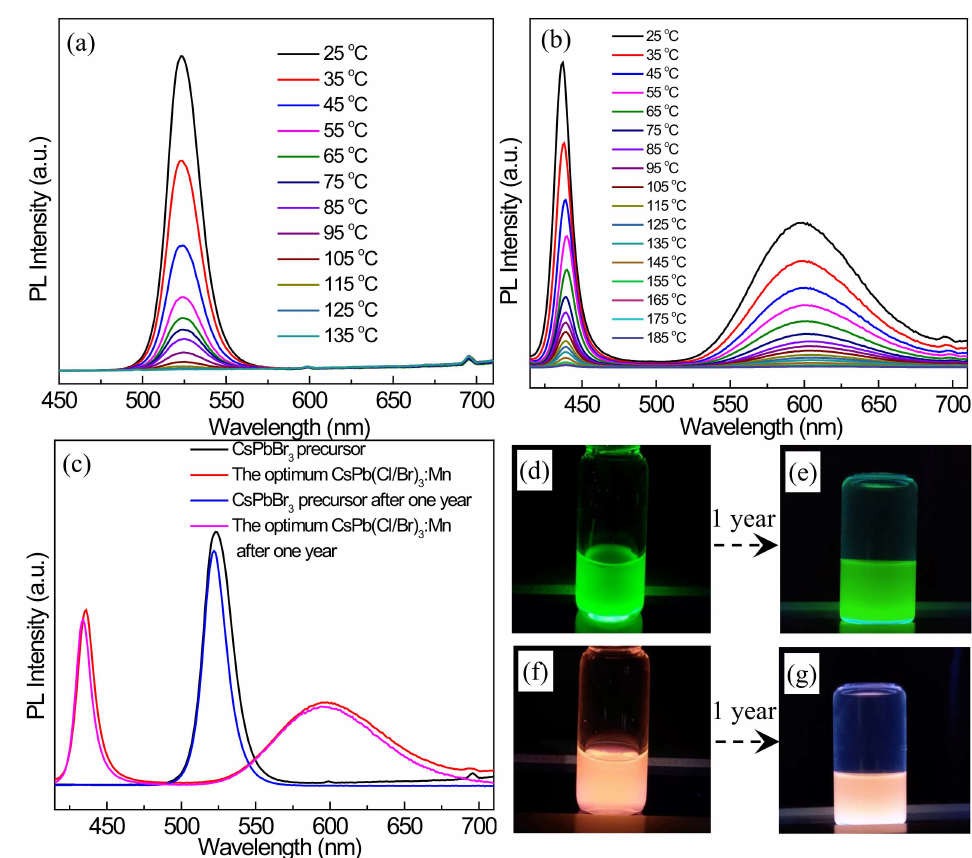
Figure 11. PL emission spectra of ( a ) the CsPbBr 3 precursor and ( b ) the optimum CsPb(Cl/Br) 3 :Mn product as the treatment temperatures increase. ( c ) PL emission spectra of the CsPbBr 3 precursor and the optimum CsPb(Cl/Br) 3 :Mn product before and after storing in air for one year. Optical images of the cyclohexane solutions containing ( d , e ) the CsPbBr 3 precursor and ( f , g ) the optimum CsPb(Cl/Br) 3 :Mn product under the environment of 365 nm light before and after storing in air for one